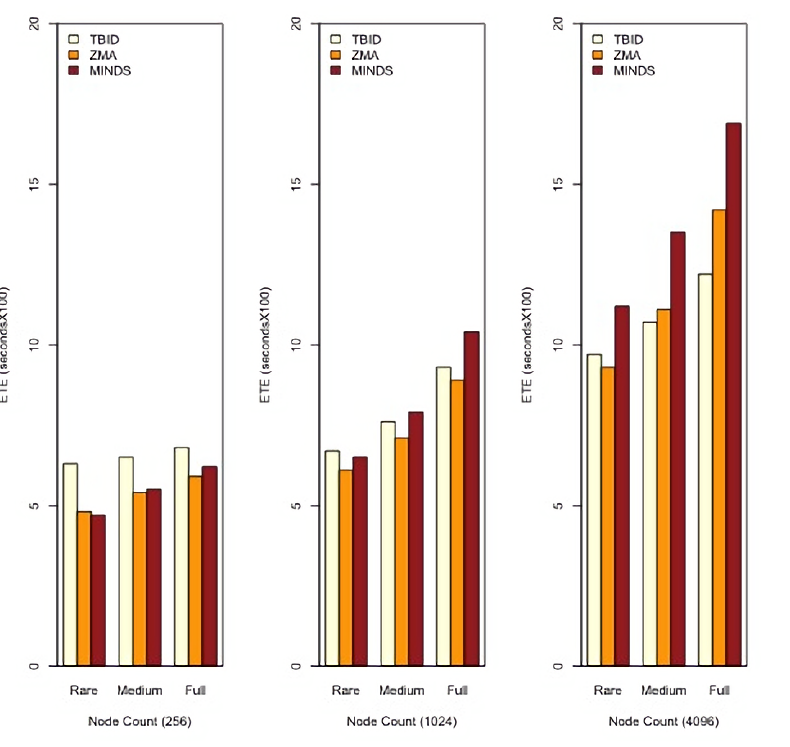
Figure 5. Average end-to-end